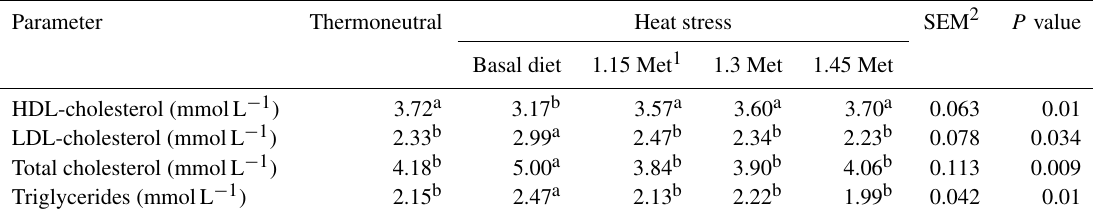
Table 9. Effect of methionine on plasma lipid parameters in breeder quails.